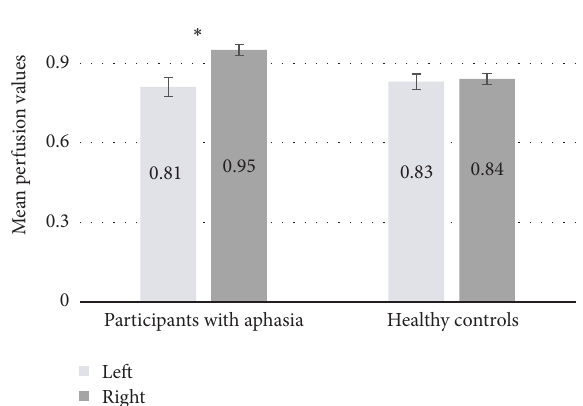
Figure 2: Mean right-occipital-normalized perfusion values for participants with aphasia and healthy controls, averaged across the 38 ROIs for the left and right hemispheres. Error bars are standard error. ∗ indicates a significant left versus right difference ( 𝑝 < .05